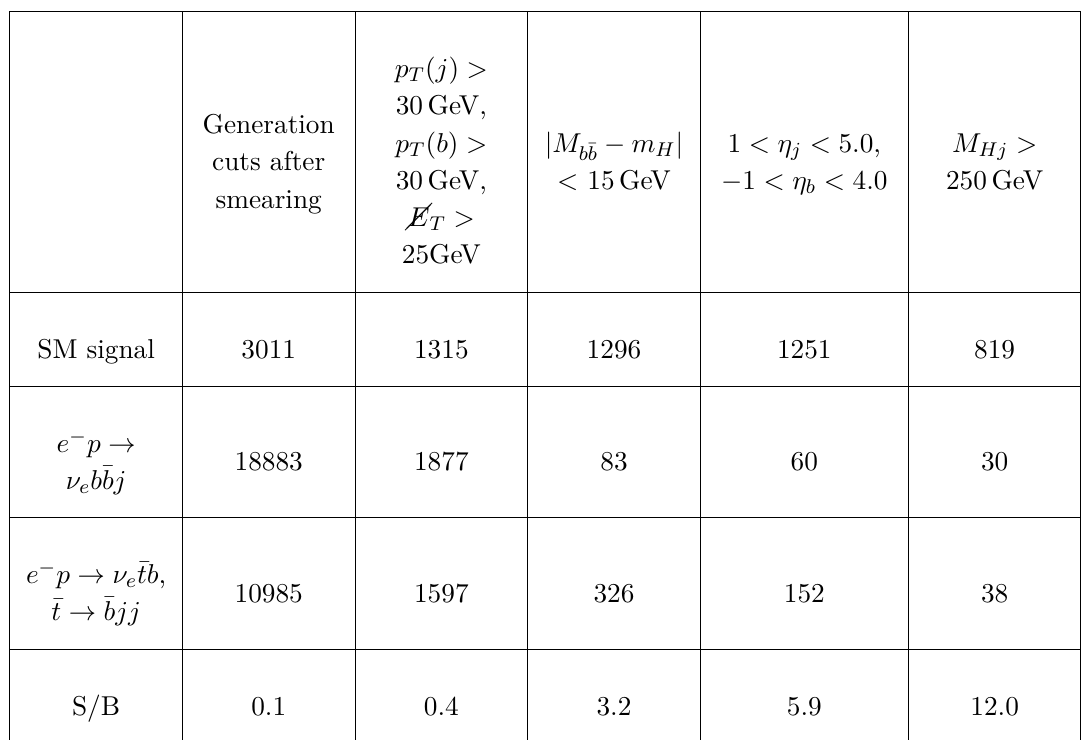
Table 1 . SM signal and background events (at L = 100 fb − 1 ) with selection cuts for the CC process. Signal to background ratio (S/B) is given in the last row. A tagging efficiency of 60% for b quark is assumed. For -80% polarized electron, the S/B ratio changes to